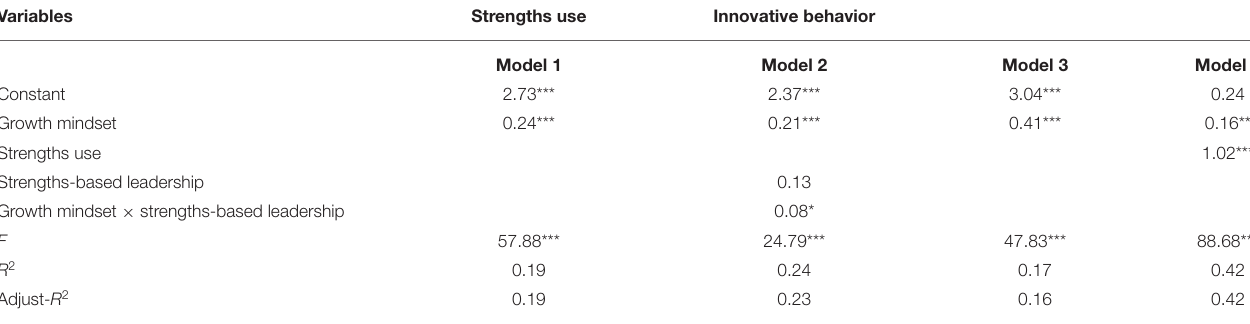
TABLE 4 | Results for multiple regression analyses with bootstrapping.